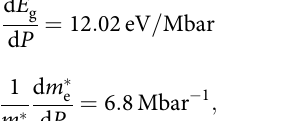
Our results are compared in Fig. 5b with the bandgap of strained GaAs calculated either from fi rst-principles (a combination of density-functional theory, DFT, with GW approximation; black dash-dotted line) or with the band-edge deformation potential (DP) theory (black short-dashed line) 49,51 .